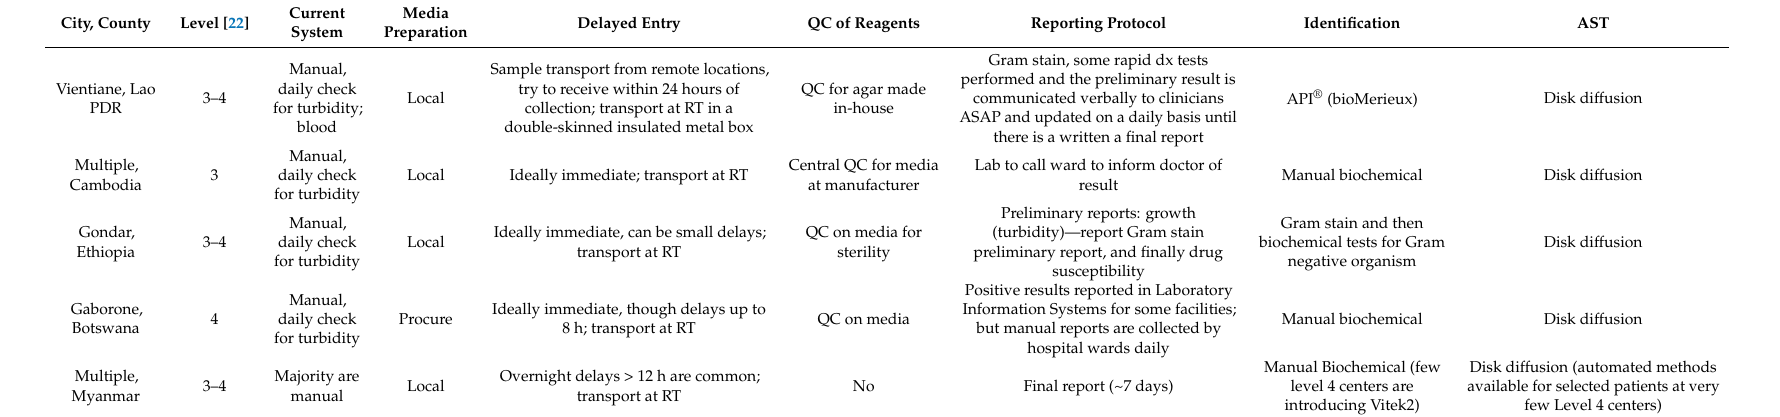
Table 1. Overview of blood culture (BC) methods in use at interviewed sites or representative countries. Only aerobic cultures were performed across all sites, and bottles were incubated for seven days. Costs at interview sites ranged from a cost of $5–7 USD per test and up to $25 USD was reported in one case. All sites currently performing BCs reported that nurses were the primary health providers collecting blood samples, though at some sites physicians (2/4, 50%) and lab technicians (1/4, 25%) also collecting samples. The expertise of the interviewees from the different countries were infectious disease physicians (Lao PDR, Myanmar, Cambodia), public health/clinical microbiologist (Ethiopia, Botswana).